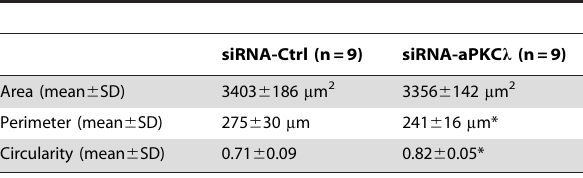
Table 1. Quantification of the effect of aPKC l depletion on the shape of the 16-cell stage